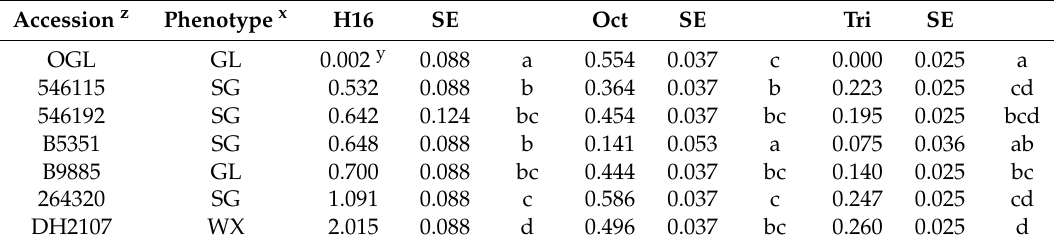
Table 2. Mean adjusted peak areas with standard errors (SE) for Hentriacontanone-16 (H16), Octacosanol-1 (Oct), and Triacontanol-1 (Tri) measured with gas chromatography mass spectrometry (GCMS) on leaves of plants from seven onion accessions (Table 1) and Tukey’s significance difference. Accessions are ranked from lowest to highest by amounts of